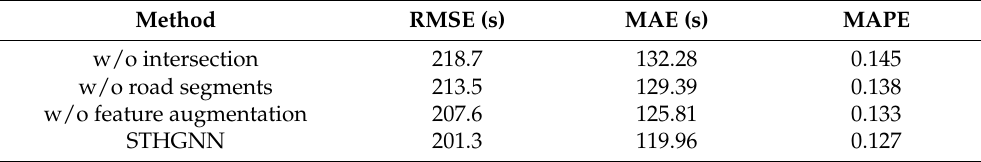
Table 4. Ablation